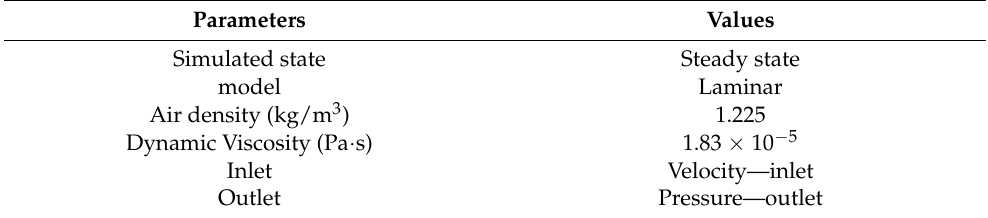
Table 3. The boundary conditions for simulating the flow field.